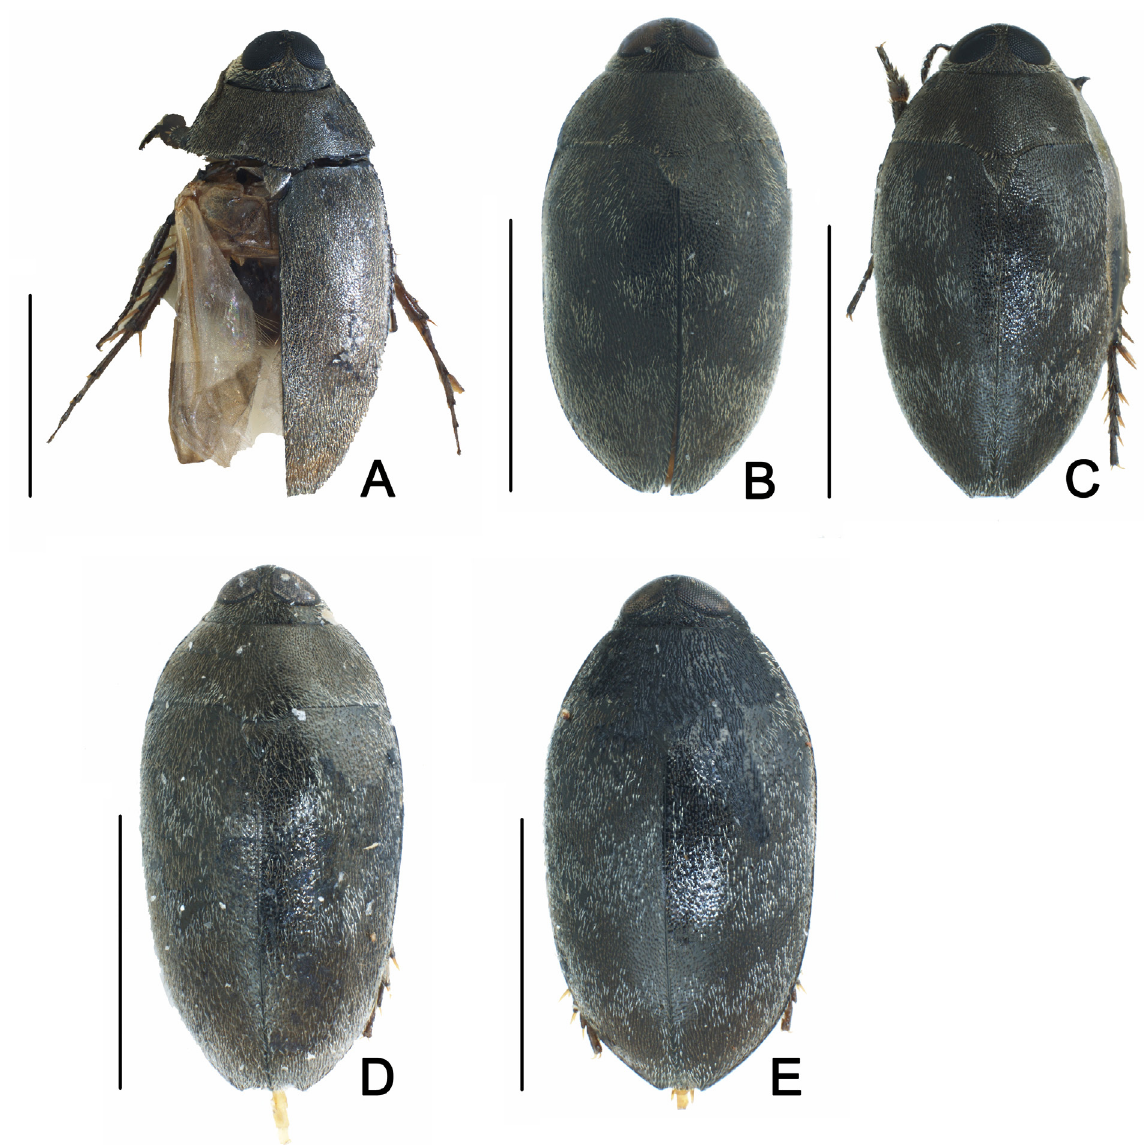
Fig. 9. Pseudeucinetus spp. A . P . papuanus sp. nov., holotype (BPBM). B . P . uenoi Spangler, 1995 (EUMJ). C . P . javanicus Yoshitomi & Putra, 2010, paratype (EUMJ). D . P . solomonicus Yoshitomi